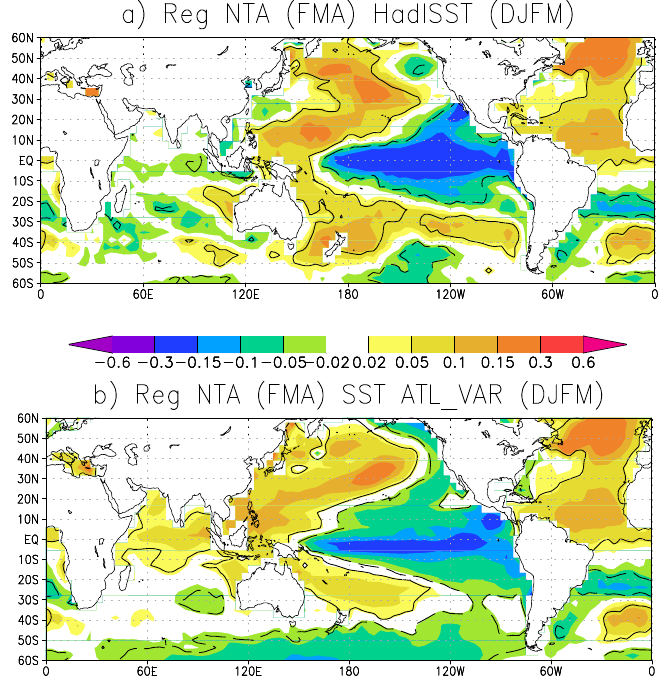
Figure 4. Regression of ( a ) observed and ( b ) ATL_VAR SSTs (DJFM) onto preceding (FMA) NTA index. Anomalies that are 95% statistically significant are indicated by contours. Units are